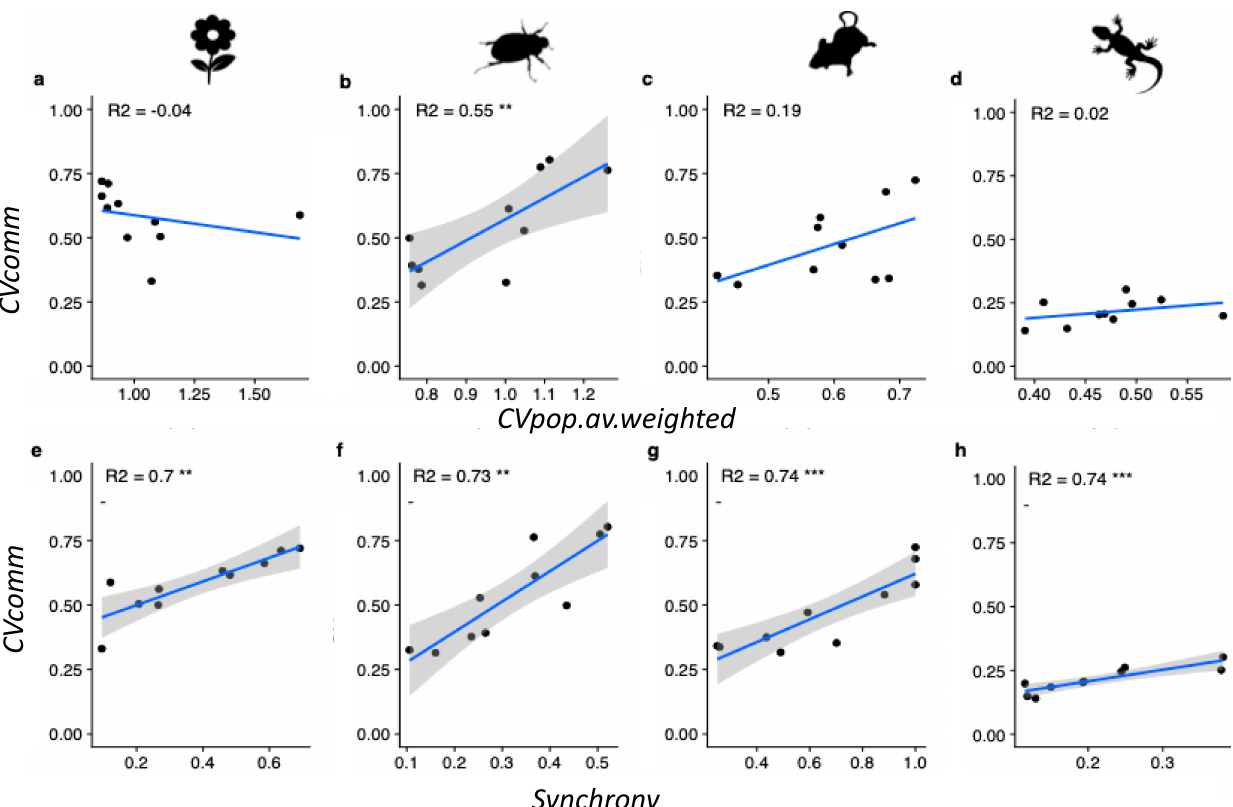
Figure 3. Regressions of ( a – d ) weighted average population Coefficient of Variation ( CVpop_av.weighted ), and ( e – h ) Synchrony ( ϕ ), against community variability (CVcomm ) for each taxon. Standard error ranges are only shown for significant regressions. Regression lines were plotted using a linear model smoothing function. Note an increase in CVcomm equates to a reduction in community stability. Explained variation (adjusted R 2 ) can be compared across parameters within each taxon. ** p < 0.01, *** p < 0.001.